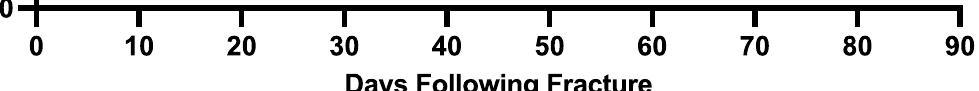
Fig 2. Incidence of venous thromboembolism following fracture or surgery. Timing of Venous Thromboembolism following a foot and ankle fracture. Nearly half of venous thromboembolism (49.8%) occurred within the first three weeks. active cancer (4.2% vs 10.8%, p < 0.001) and have had surgery for their fracture (6.9% vs 4.6%) (p < 0.001 for reach). Patients who had a VTE were more likely to have an ankle fracture (39.9% vs 30.0%) and multiple fractures (6.8% vs 4.8%), while being less likely to have a tarsal